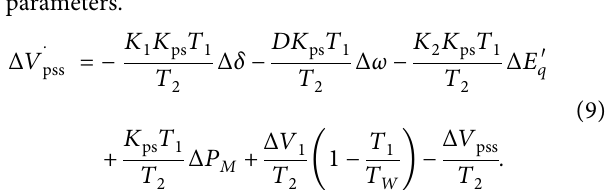
Figure 1: PSHPP with